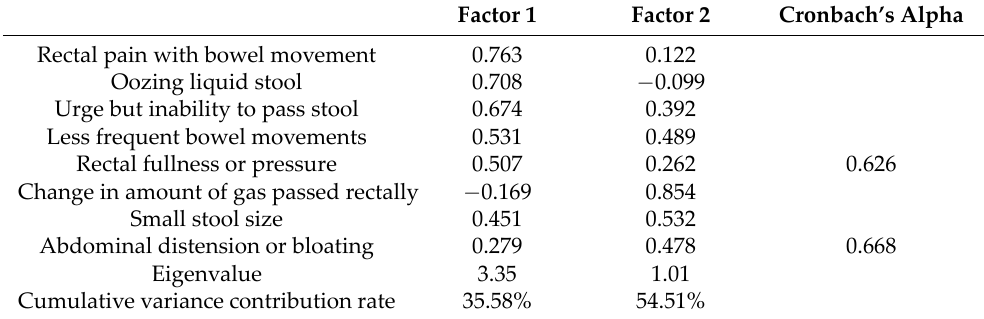
Table 5. Principal factor extraction and factor loadings of each item of